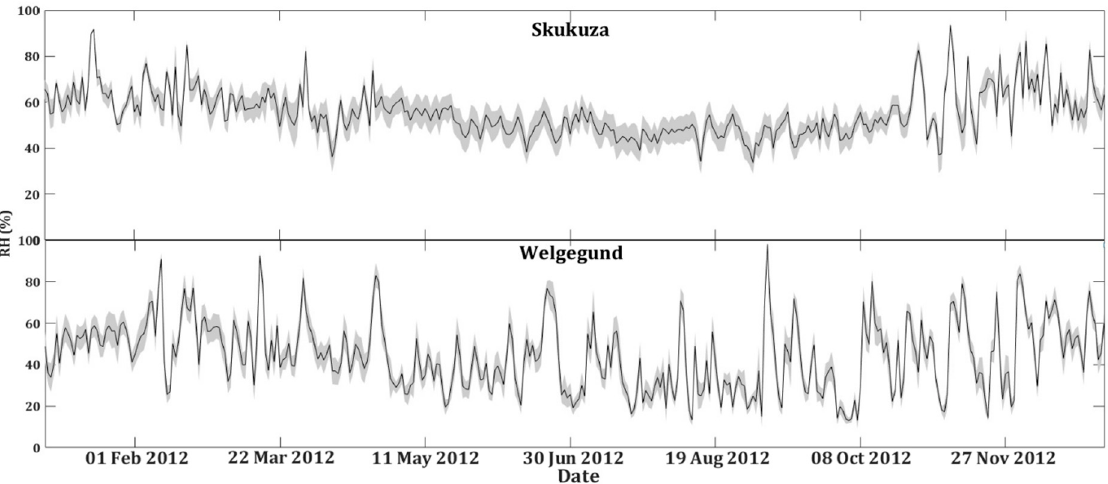
Figure 3. Daily average relative humidity of year 2012 for the two study sites. The grey bounds indicate the absolute uncertainties, which were added as standard deviations.